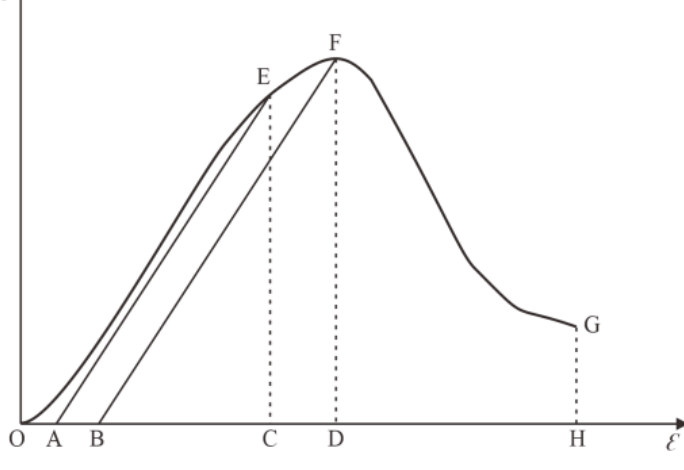
Figure 8. Rock energy characteristic index.